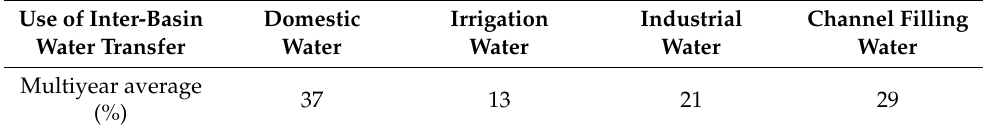
Table 2. The average proportion of multi-year use of inter-basin water transfer. Use of